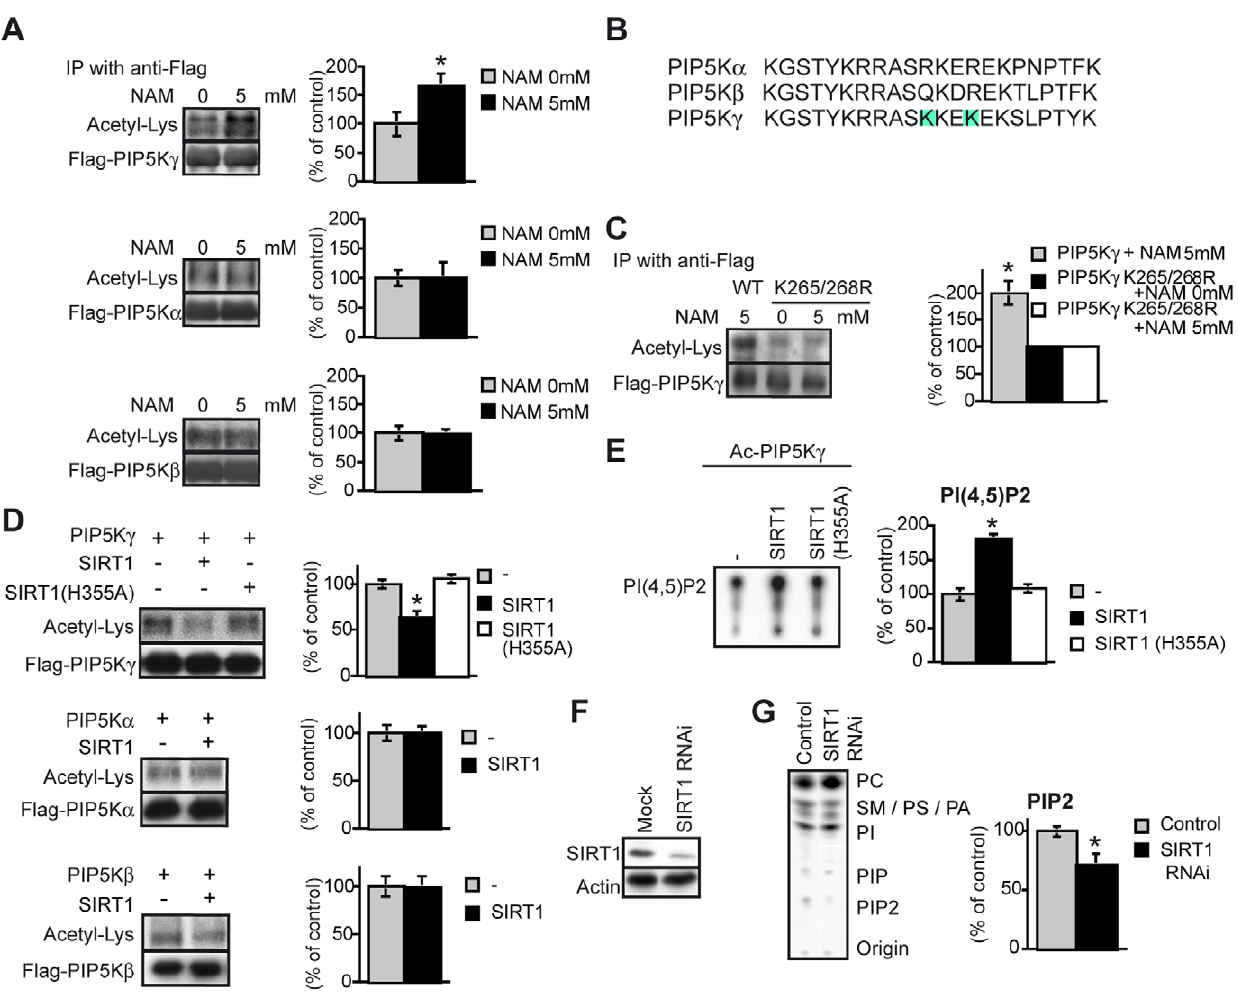
Figure 4. Activation of PIP5K c by deacetylation. (A, C) Effects of NAM on the acetylation of PIP5Ks (A) and PIP5K c K265/268R (C). The level of acetylated-lysine/PIP5K level was determined. Statistical analyses were performed using Student’s t test ( n =3). * P , 0.05 versus the non-NAM-treated group. (B) Sequence alignment of PIP5Ks. PIP5K a (amino acids 205–226), PIP5K b (246–267), and PIP5K c (255–276) are shown. The light blue columns indicate candidates for deacetylation site by SIRT1. (D) In vitro deacetylation of PIP5Ks by SIRT1. Each Flag-PIP5Ks were purified from HEK293T